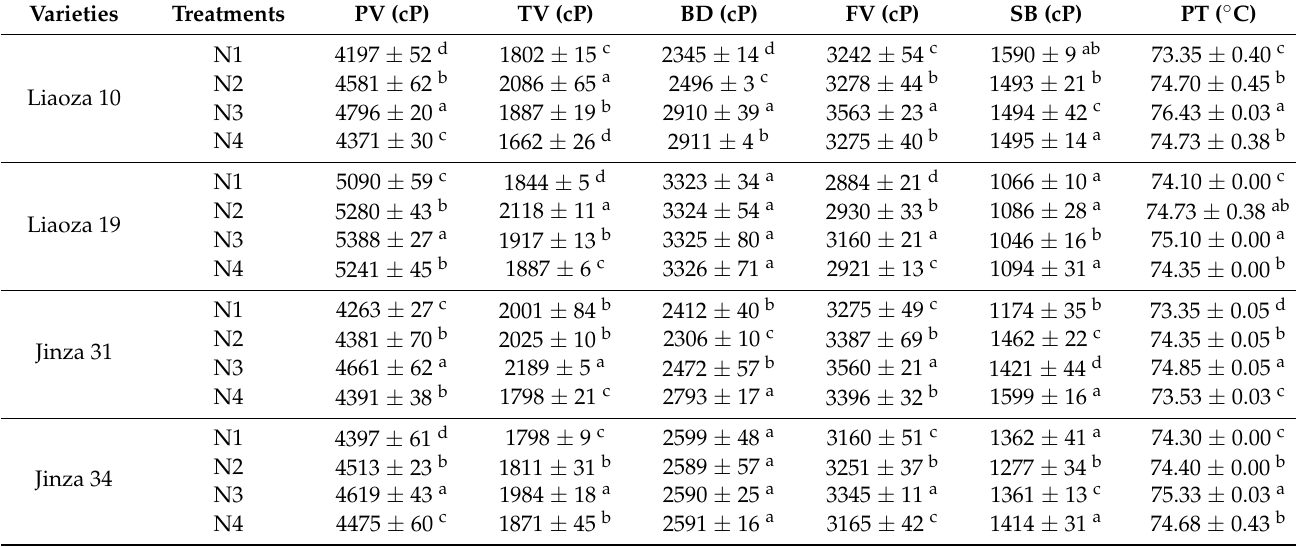
Table 3. Effects of different nitrogen fertilizer level on the gelatinization of sorghum starch. Varieties